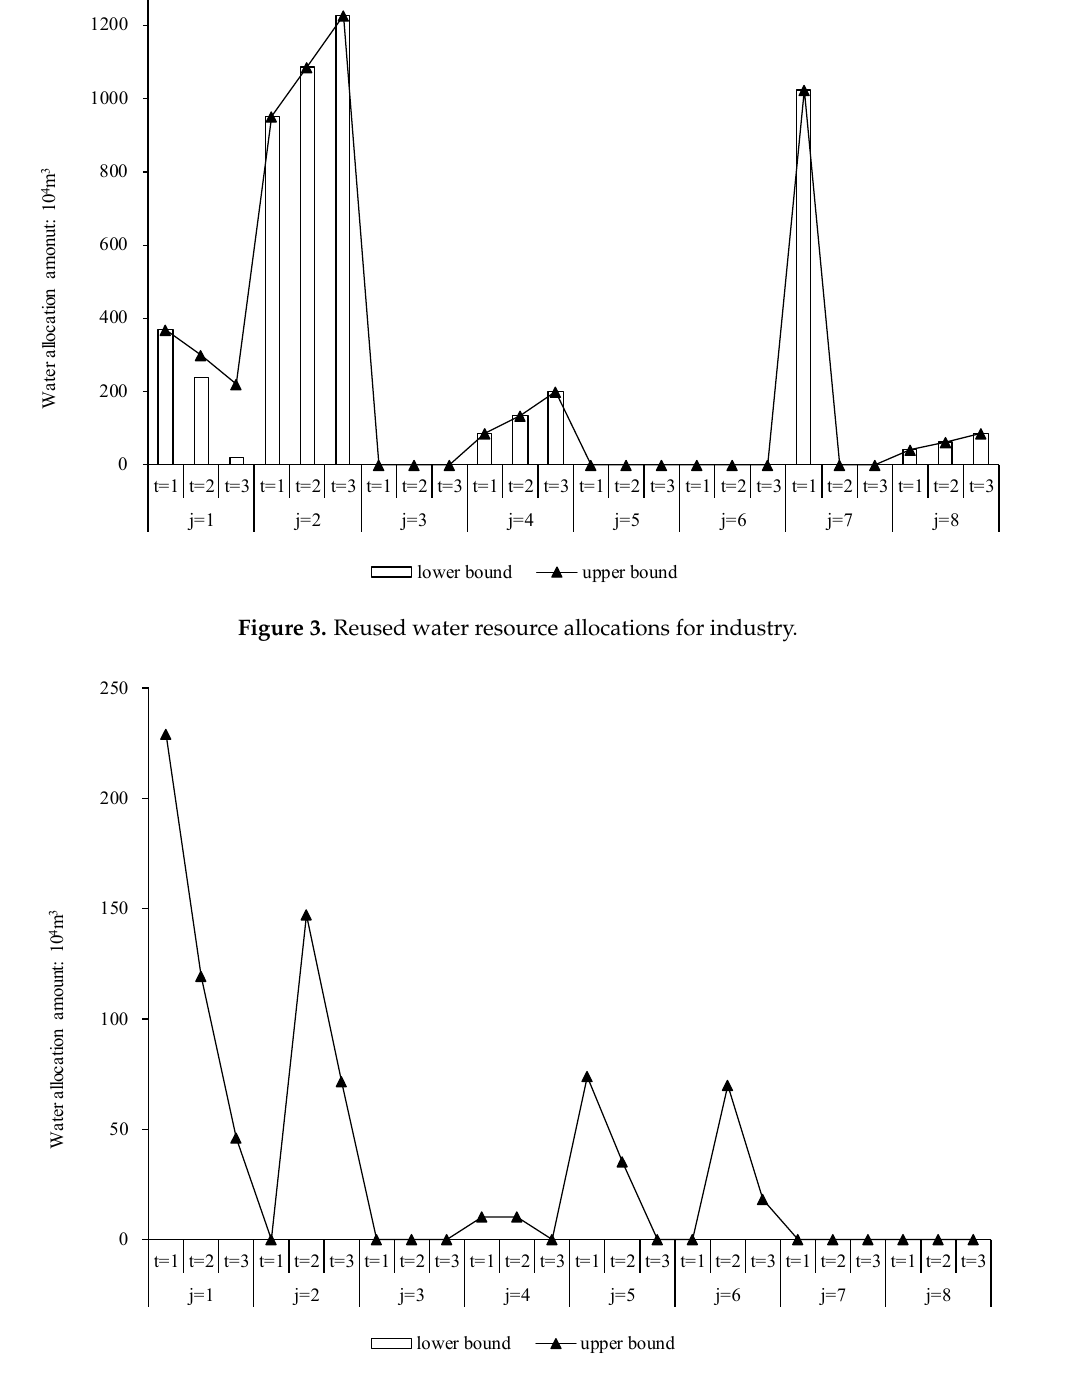
Figure 4. Reused water resource allocations for municipal use.